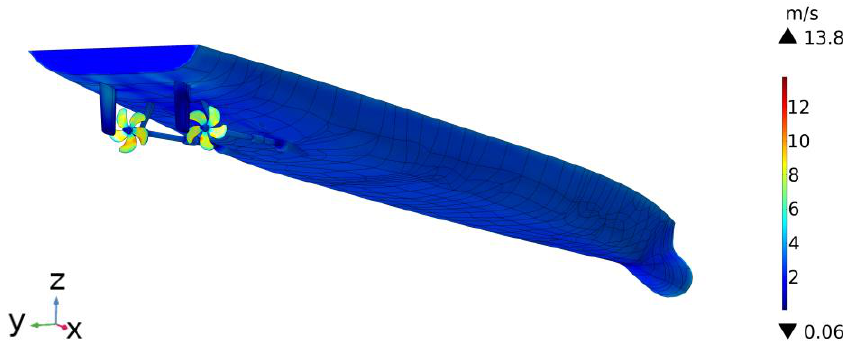
Figure 4. Velocity distribution on the surface of the ship hull.